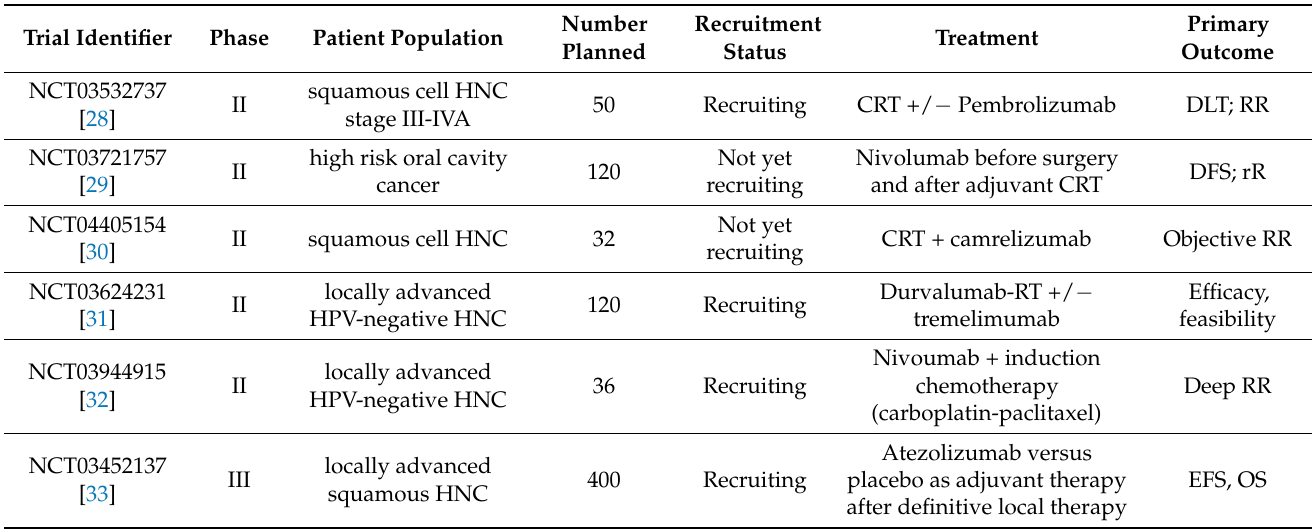
Table 2. Ongoing trials testing immune check-point inhibitors in addition to definitive chemoradiotherapy in head and neck cancer